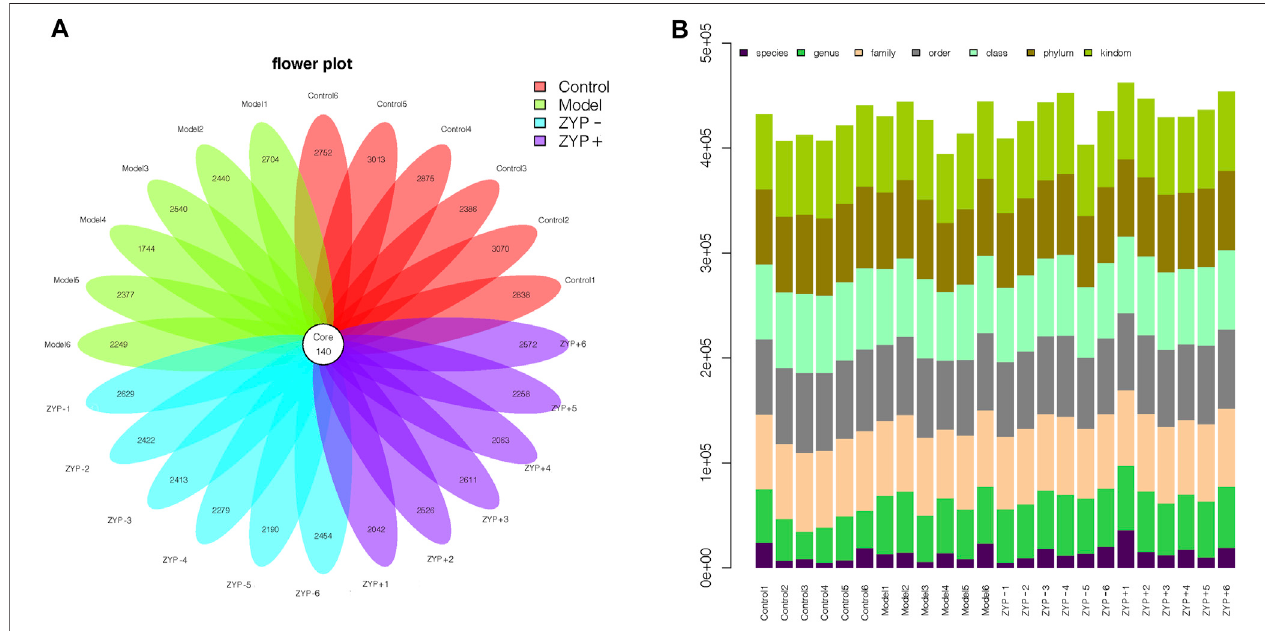
FIGURE 5 | OTUs classi fi cation results. (A) Operational Taxonomic Units (OTUs) based petal maps; (B) Comment situation of tags.